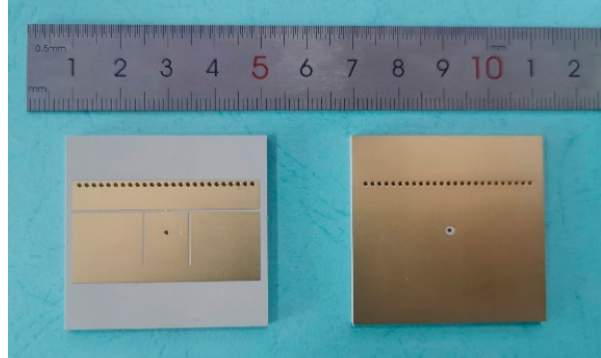
Figure 7. Photograph of the fabricated antenna.